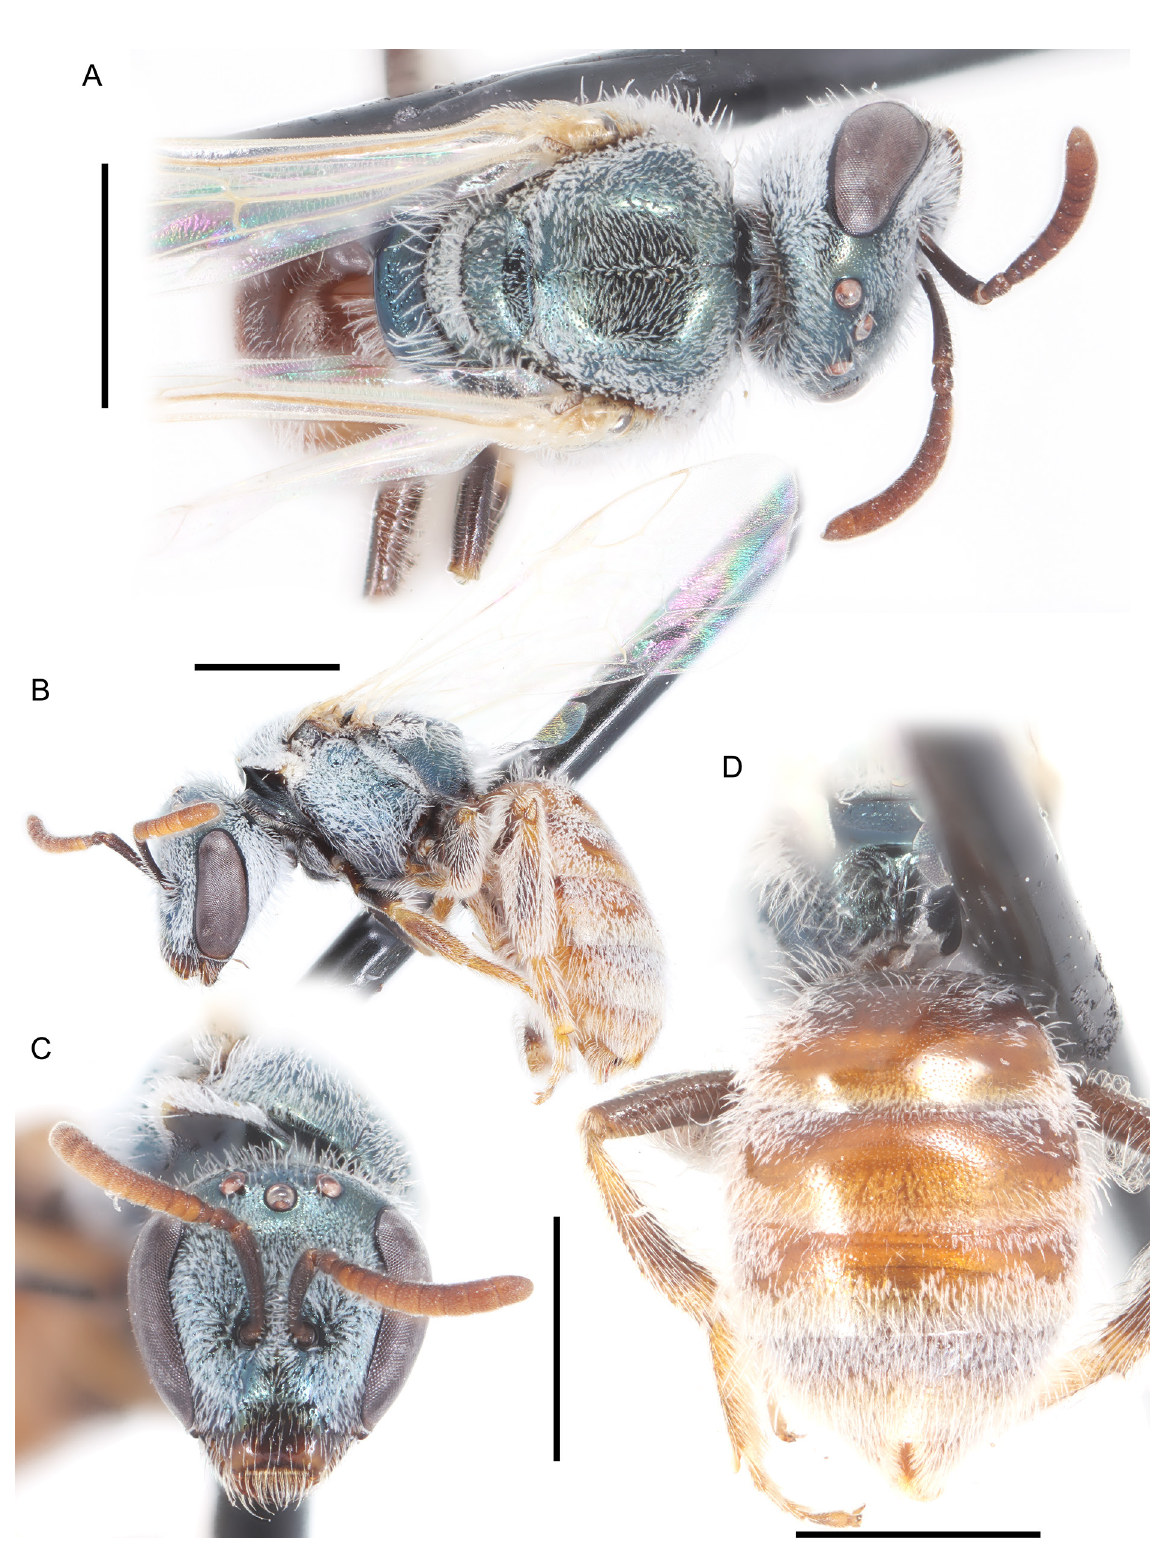
Fig. 52. Lasioglossum ( D. ) lilianae sp. nov., ♀. A . Dorsal habitus. B . Lateral habitus. C . Face. D . Propodeum and metasoma. Scale bars: 1